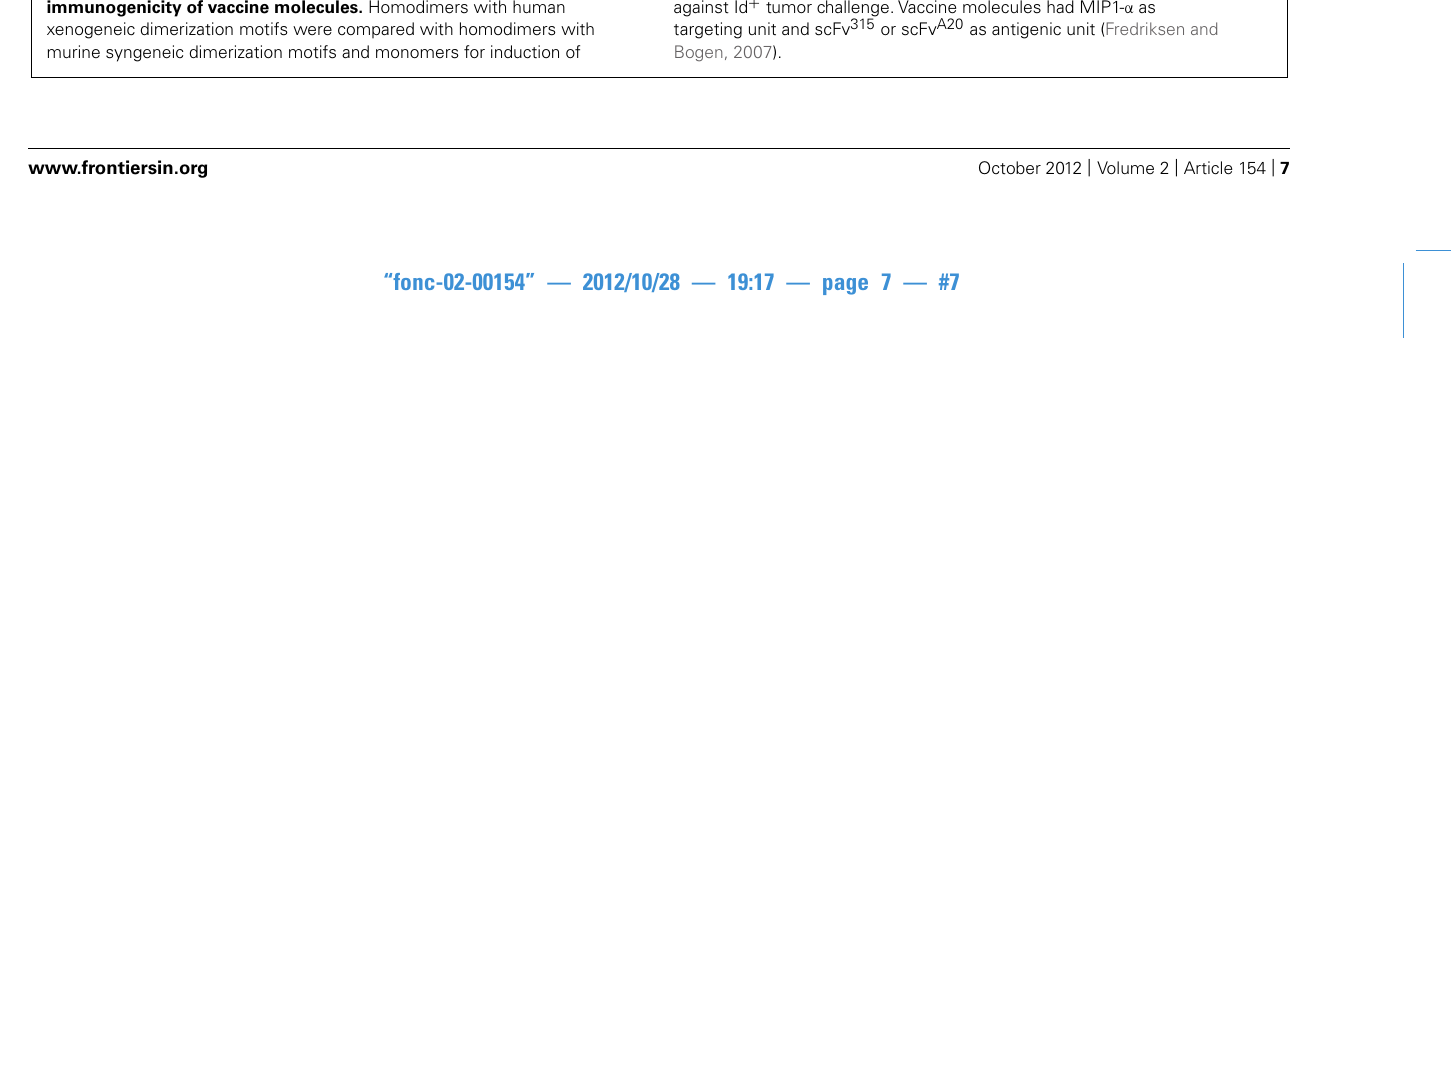
chemotaxis, Id-specificT and B cell responses, and protection against Id + tumor challenge.Vaccine molecules had MIP1- α as targeting unit and scFv 315 or scFv A20 as antigenic unit (Fredriksen and Bogen,